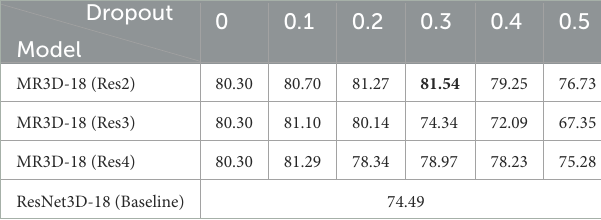
TABLE 2 Ablation study of MR3D-18 network in terms of top 1 score ( % ) on the MIT-STAG dataset.